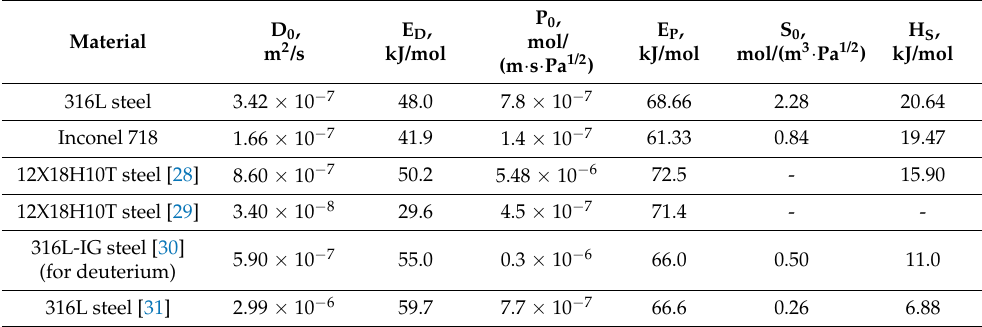
Table 5. Kinetic parameters of high-temperature hydrogen permeability for SLM specimens and specimens processed